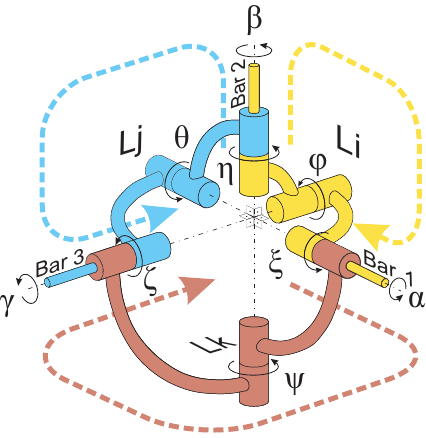
Figure 5. Loop coupling conditions at a multiple spherical